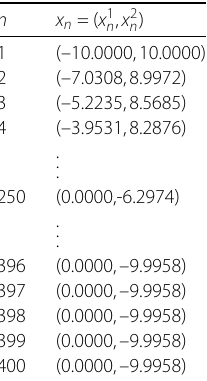
Figure 2 The convergence of { x n } with x 1 n = –10, x 2 n = 10, and n = N =